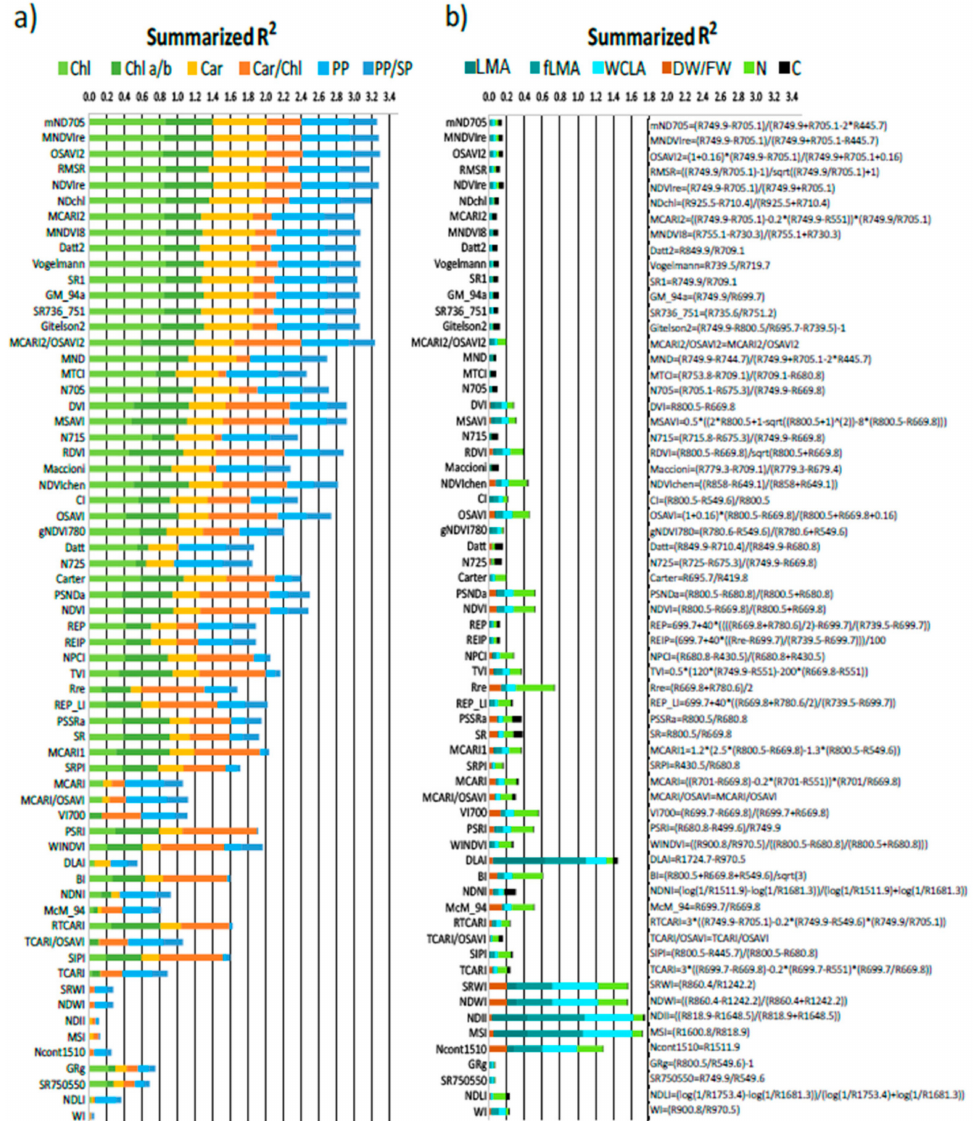
Figure 9. Summarized correlation coefficient R 2 of parameters connected with photosynthetic pigments ( a ) Chl: chlorophyll a + b content (light green); Chl a/b: chlorophyll a/b ratio (dark green); Car: carotenoids content (yellow); Car/Chl: carotenoids/chlorophyll ratio (orange); PP: palisade parenchyma thickness (blue color); PP/SP: palisade/spongy parenchyma thickness ratio (dark blue); and parameters connected with dry matter ( b ) LMA: leaf mass per area (dark cyan); fLMA: fresh leaf mass per area light cyan); WCLA: water content per leaf area (light blue); DW/FW: dry/fresh weight ratio (brown); N: nitrogen content (light green); C: carbon content